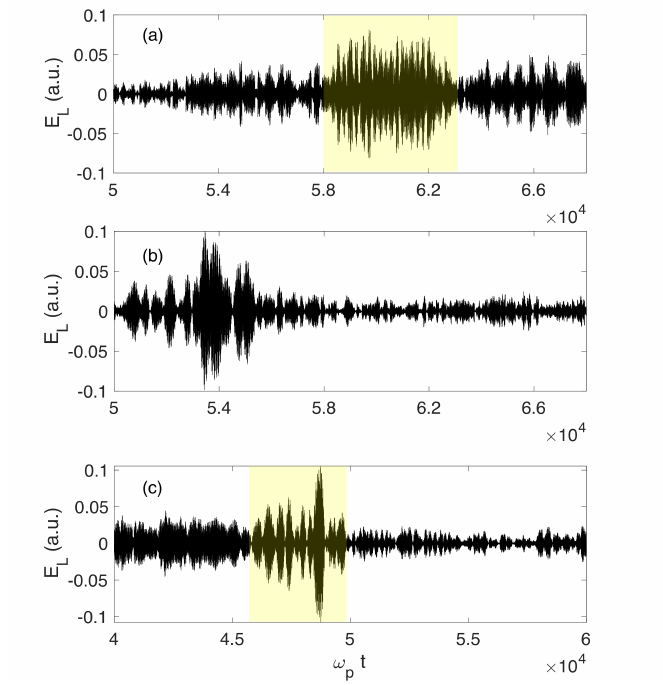
Figure 11. Langmuir waveforms (registered electric fields E L as a function of time) observed by a virtual satellite moving at the velocity v S = 0.1 v T and starting at time ω p t = 50,000 when ( a ) it crosses a plasma region where wave decay occurs, ( b ) it crosses no region with decay. ( c ) Langmuir waveform observed by a virtual satellite moving with v S = 0.15 v T , starting at ω p t = 40,000 and crossing a plasma region with wave decay. Main parameters are the following: ( a , b ) ∆ n = 0.02, ( c ) ∆ n = 0.03. Regions showing specific modulations due to wave decay are colorized. All variables are